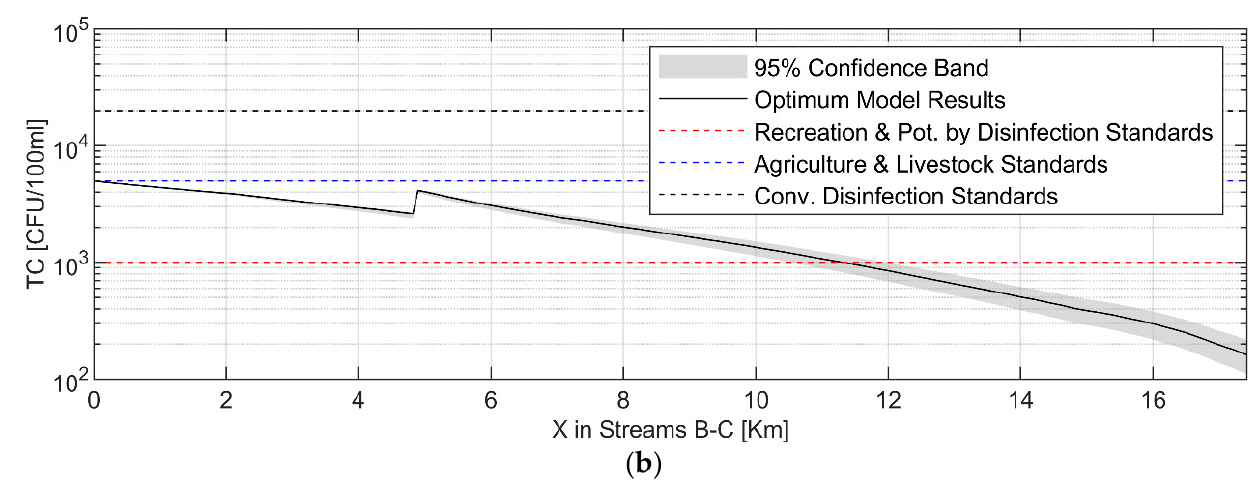
Figure 11. Model results for total coliforms in: ( a ) alternative scenario 1; ( b ) alternative scenario 2.